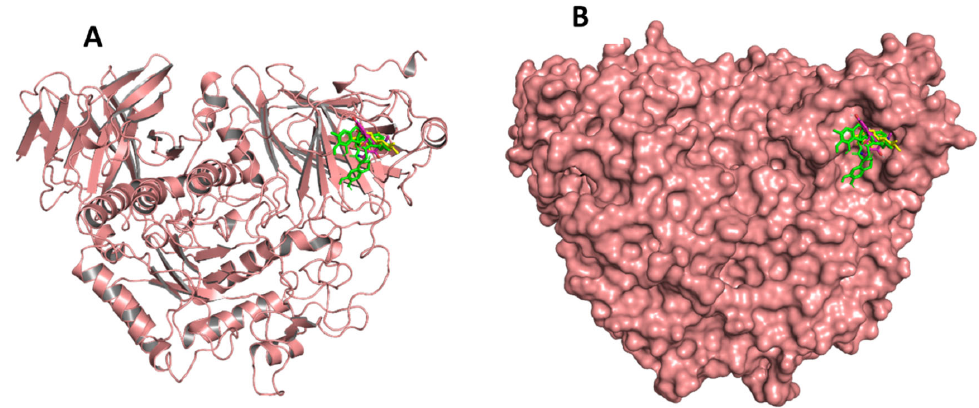
Figure 9. The ROC curve for the validation of docking and the area under the ROC curve calculation quanti fi es the overall docking results. The green line represents AUC (0.822). Before simulation, two lead compounds and the active compound were superim- posed and analyzed. The active compound and lead compounds bind in the active site and interact with di ff erent residues, as shown in Figure 10 in cartoon and surface form.